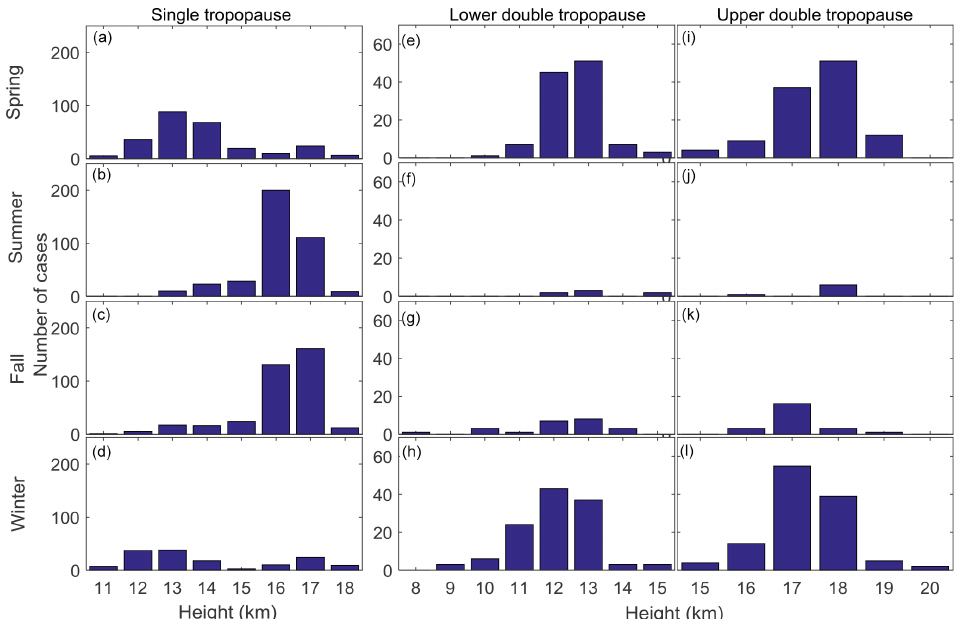
Figure 13. (a–d) Altitude distribution of the tropopause above TMF for spring, summer, fall and winter, respectively, and in the absence of double-tropopause. (e–h) Altitude distribution of the lower (first) tropopause above TMF for spring, summer, fall and winter, respectively, and in the presence of a double-tropopause. (i–l) Same as panels (e–h) but for the upper or second tropopause. All computations were made at the times of the TMF lidar measurements.